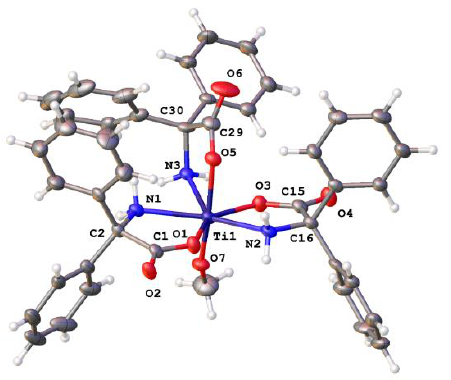
Figure 6. Asymmetric unit of 6 · 2.5MeCN with atoms drawn as 50% probability ellipsoids. Selected bond lengths (Å ) and bond angles ( o ): Ti(1)-O(5) 1.984(2), Ti(1)-O(1) 2.019(2), Ti(1)-O(7) 1.772(2), Ti(1)-O(3) 2.042(2), Ti(1)-N(3) 2.245(3), Ti(1)-N(1) 2.262(3), Ti(1)-N(2) 2.237(3); O(5)-Ti(1)-O(1)